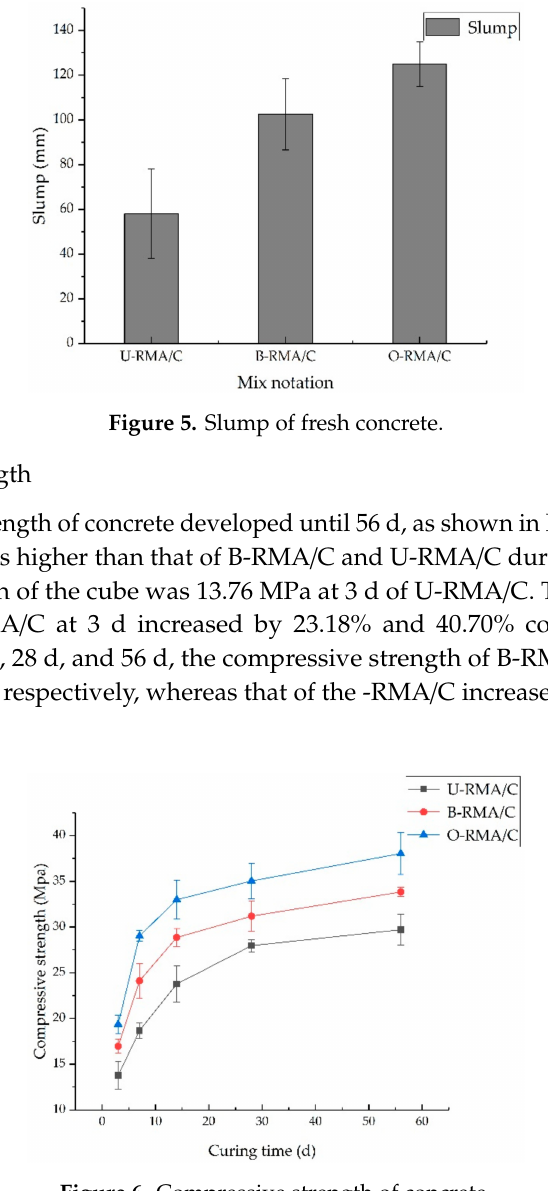
Figure 6. Compressive strength of